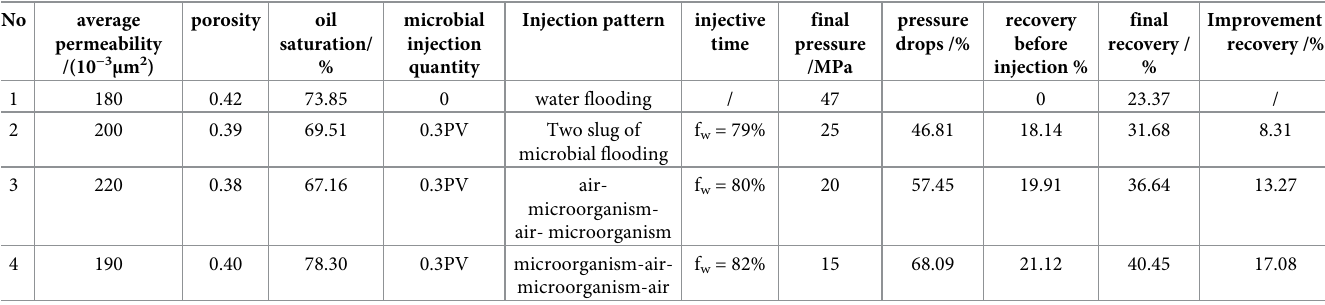
Table 6. Main results of microbial oil displacement